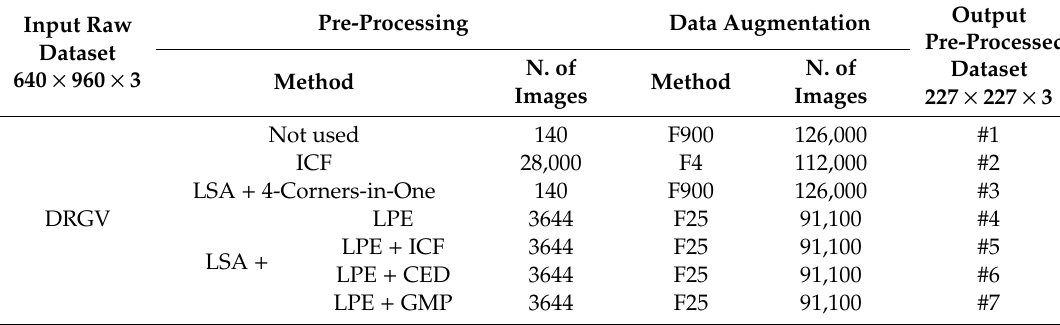
Table 2. Statistics of the used pre-processed datasets from the DRGV image